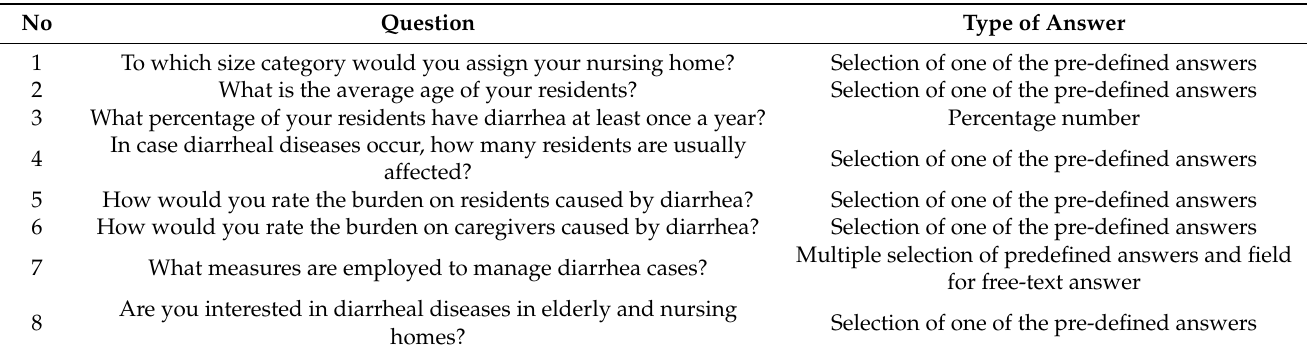
Table 1. Questions in the